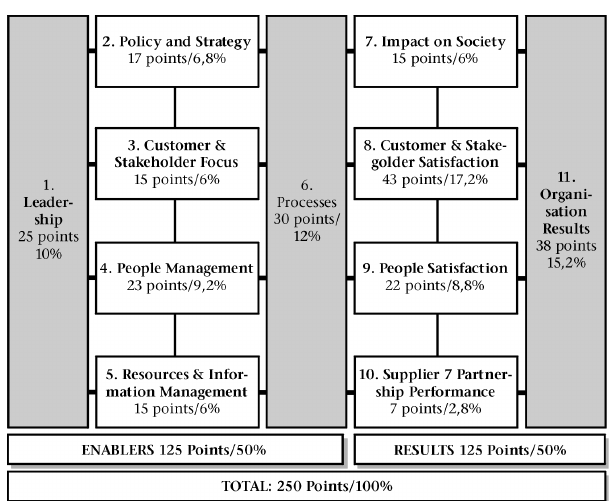
Figure 1: South African excellence model for public service performance excellence (South African Excellence Model,